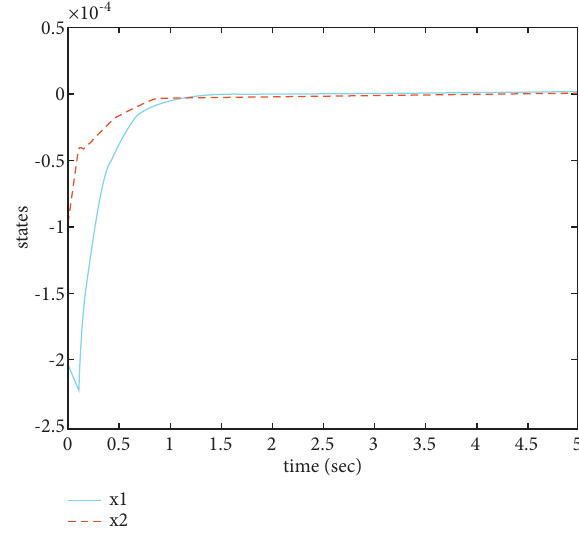
Figure 1: The state response of System (35) without